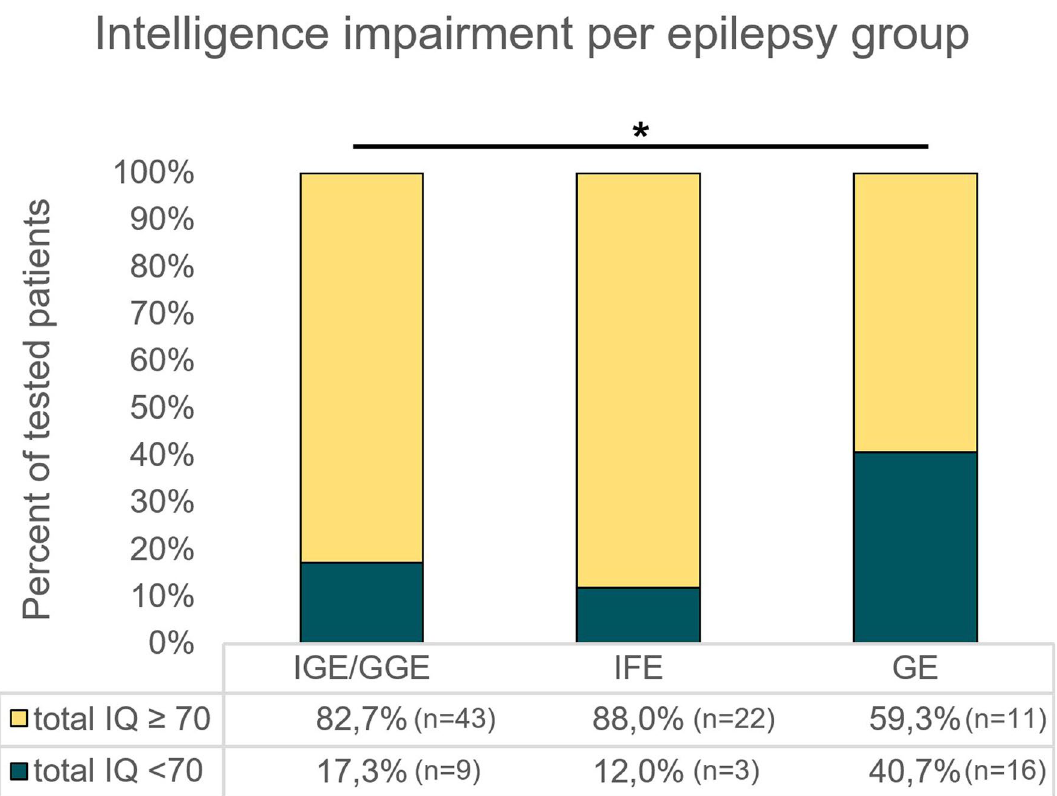
Figure 3. Intelligence impairment comparison in percentage of impaired children per epilepsy group with total numbers included in accompanying table. * p = 0.033.